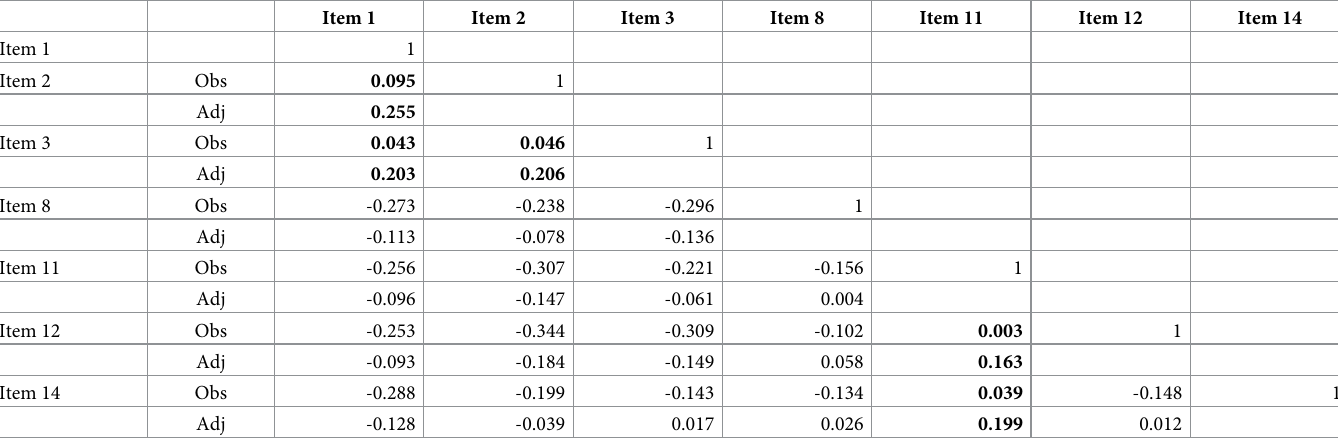
Table 2. Residual correlations of the negatively worded items.